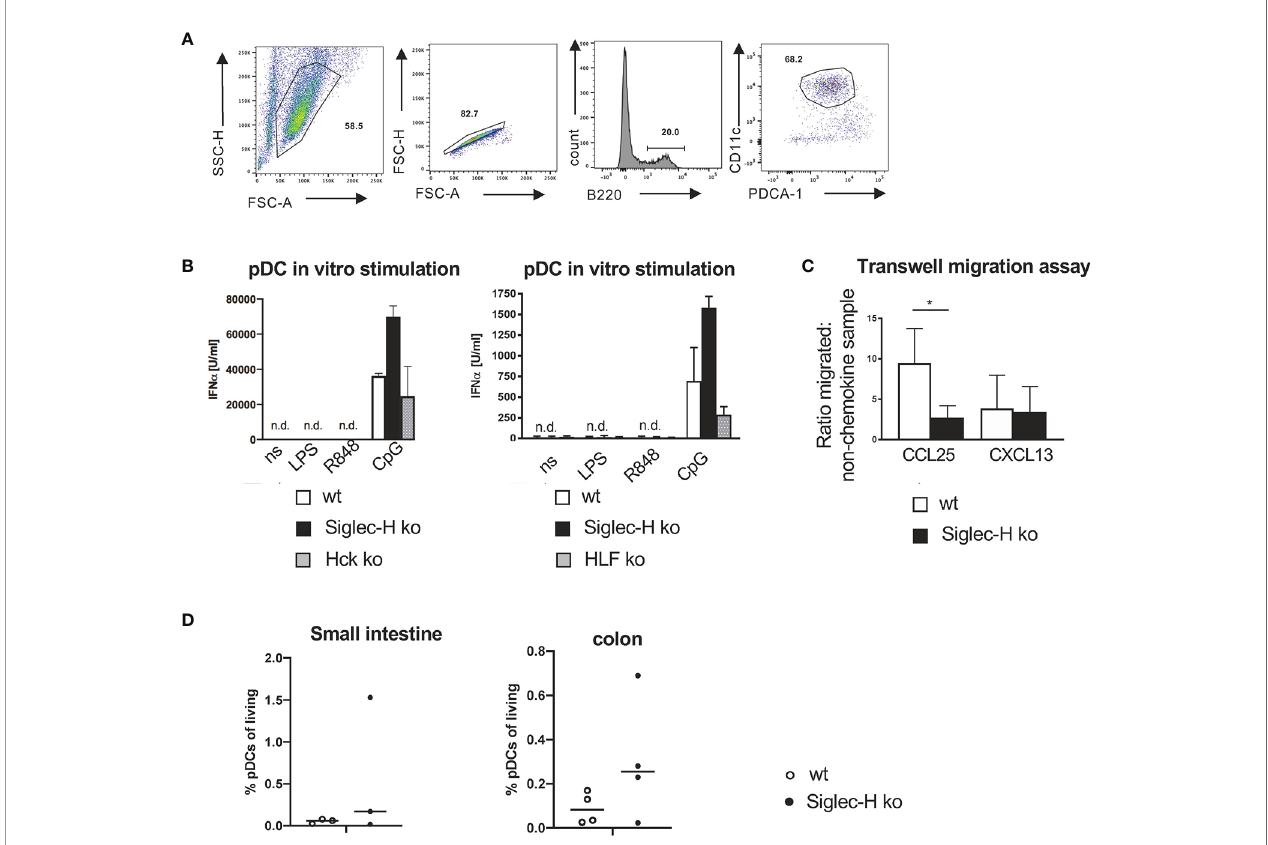
FIGURE 7 | No in fl uence of Hck in pDCs on the IFN- a production and reduced in vitro migration of Siglec-H ko pDCs to CCL25. (A) Strategy to sort pDCs from B16Flt3L-treated wt and Siglec-H ko spleens to use in transwell-migration assays (purity more than 90%). (B) In vitro generated pDCs from wt, Siglec-H ko and HCK ko or HFL KO mice were stimulated for 24 hrs with LPS (c=1 µg/ml), R848 (c=4 µg/ml) or CpG A (c=2,5 µg/ml) (two separate experiments are shown). The amount of IFN- a was measured by ELISA. White bars: wt, black bars: Siglec-H ko, grey bars: HCK ko (left), HFL ko (right). n.d.: not detectable. N=3 mice per genotype. Error bars are mean ± SD values. (C) Sorted pDCs were used in a transwell-migration assay to evaluate migratory capacity towards CCL25. CCL25 or CXCL13 were given in the lower chamber of the transwell and sorted pDCs were given into the upper chamber. pDCs could then migrate towards CCL25 or CXCL13 for 2 hrs. Migrated cells were counted in the lower chamber and a ratio in relation to the sample with no-chemokine in the lower chamber was calculated. As a negative control CXCL13 was used. CCL25 c= 125nM, CXCL13 c= 100nM. Ratio of migrated cells to non-chemokine control is displayed. Summary of three independent experiments with N=5 mice per genotype. Mice were aged 10-16 weeks. Mann-Whitney test, *p < 0,05. Error bars are mean ± SD values. (D) Leukocytes from the small intestine and bowel were isolated and stained as shown in Supplementary Figure 4C . pDC percentages are shown as % of living leukocytes. Mice were aged 10-16 weeks, N=3 mice per